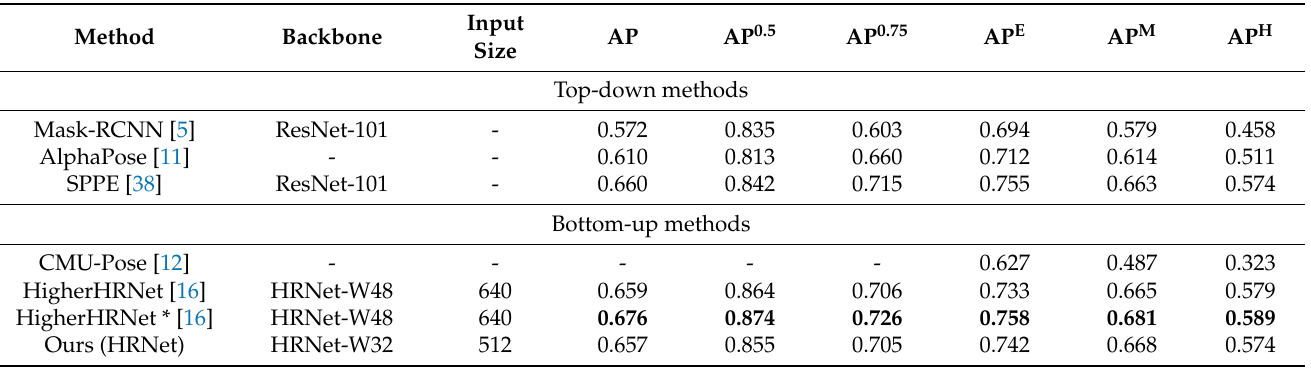
Table 4. Comparisons of our model to other state-of-the-art models on the CrowdPose test dataset. Superscripts E, M, H of AP stand for easy, medium and hard. * indicates multi-scale testing. The highest values are indicated in